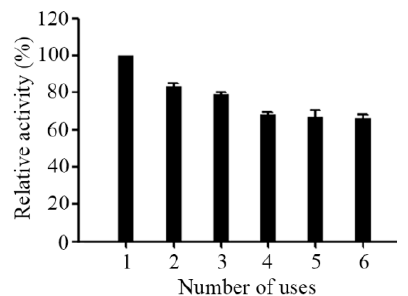
Figure5. ReusabilityofimmobilizedAly08. Figure 5. Reusability of immobilized Aly08. Activity for each cycle was compared with the initial activity.